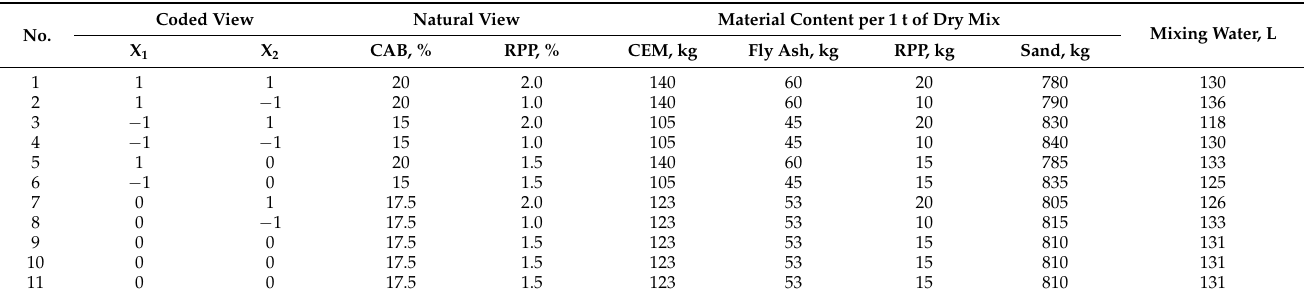
Table 6. Planning matrix and composition of mixtures.